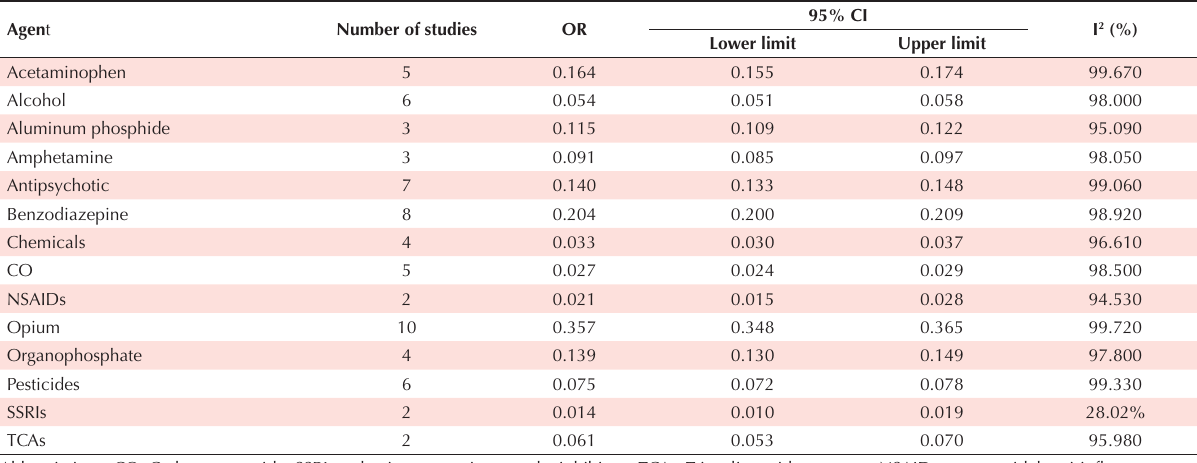
Table 2. Meta-analysis of poisoning ratio based on the